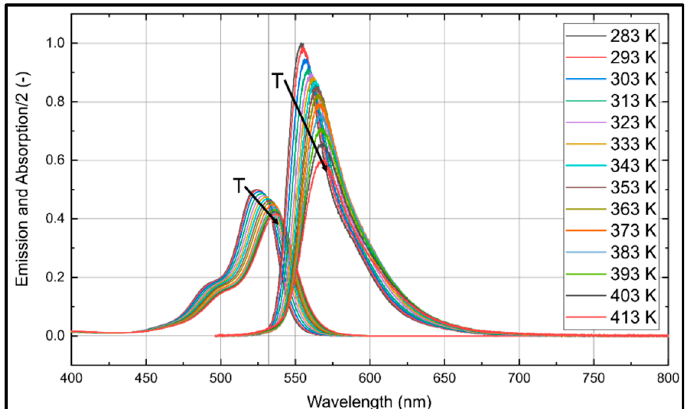
Figure 8. Normalized absorption ( left curves) and emission spectra ( right ) for Eosin-Y (15.86 mg/L) dissolved in ethanol for various temperatures, 0.1 MPa (Please note that the absorption signal is divided by factor of 2 for clarity); the spectra are normalized to the maximum peak signal at 283 K.